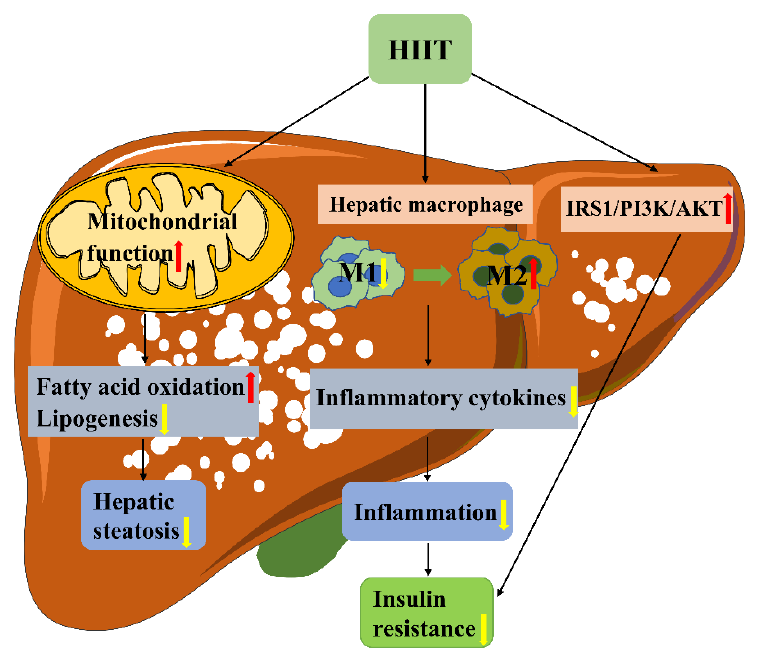
Figure 9. Mechanism of HIIT improving liver inflammation and insulin resistance in T2DM mice.